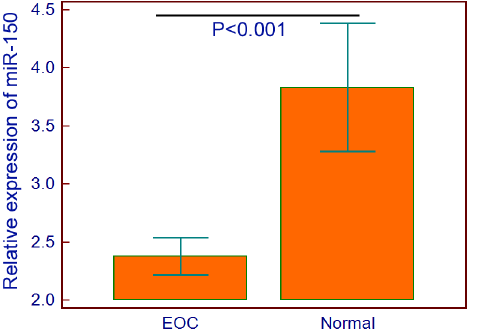
Figure 1. Expression levels of miR-150 in 100 EOC tissue specimens and 10 normal ovarian tissue specimens were detected by qRT-PCR and normalized to RNU6B. The results showed that the expression level of miR-150 in EOC tissues was significantly lower than that in normal ovarian tissues (EOC vs. Normal: 2.38 6 0.80 vs. 3.83 6 0.77, P , 0.001).